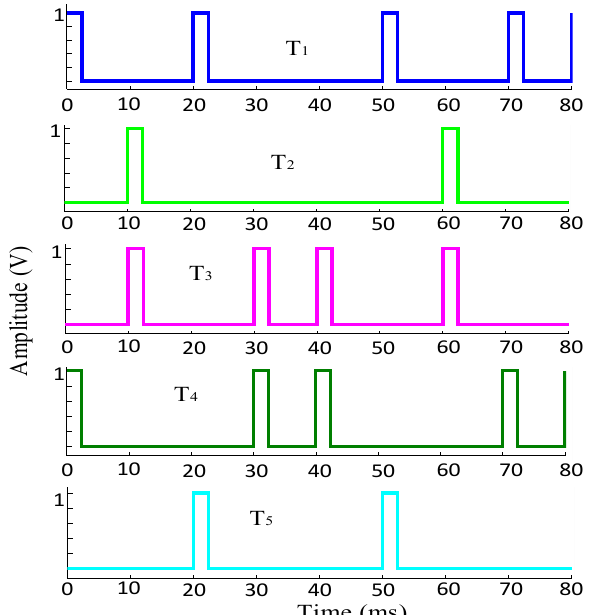
Figure 6 . Firing pulses of different Triac of proposed cycloconverter for one − third conversion of 50 Hz.